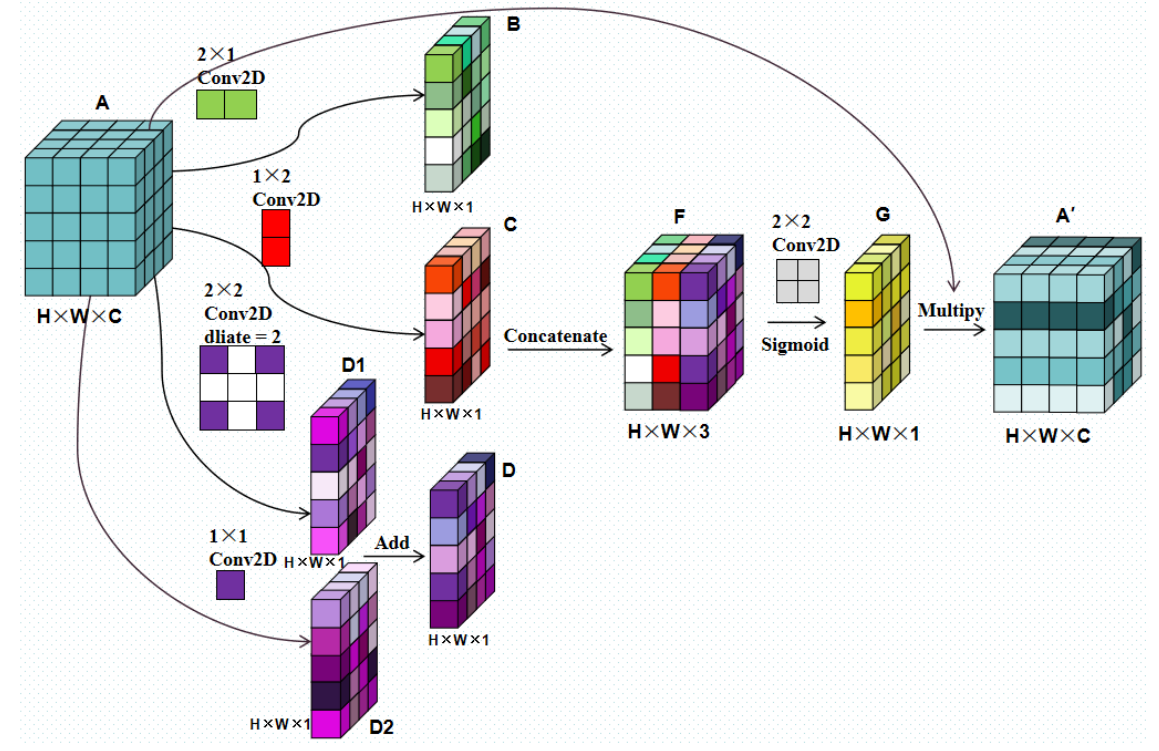
Figure 9. PDMA mechanism structure.